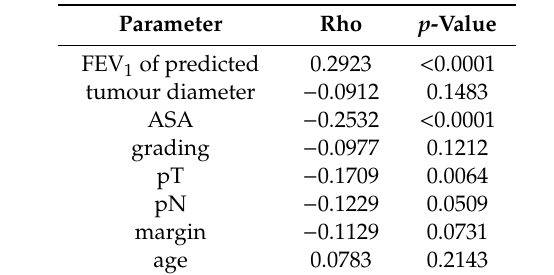
Table 4. Correlation of peak oxygen consumption (VO 2 peak of predicted) with other parameters (n = 253; Spearman’s rank correlation test).